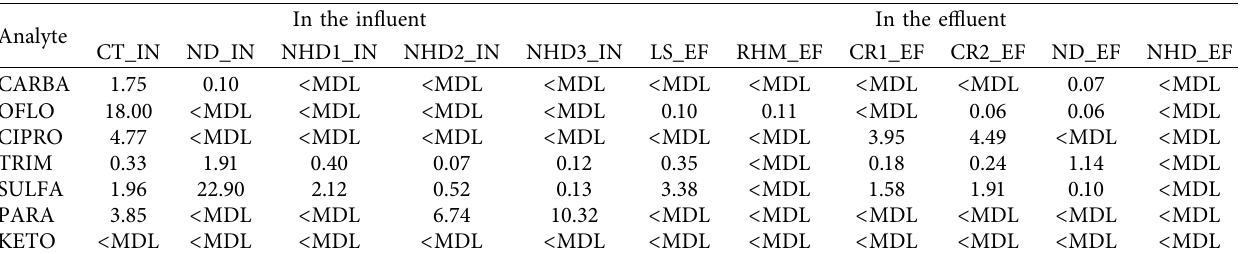
Table 4: Concentration of target pharmaceutical residues ( µ g L − 1 ) in hospital wastewater.